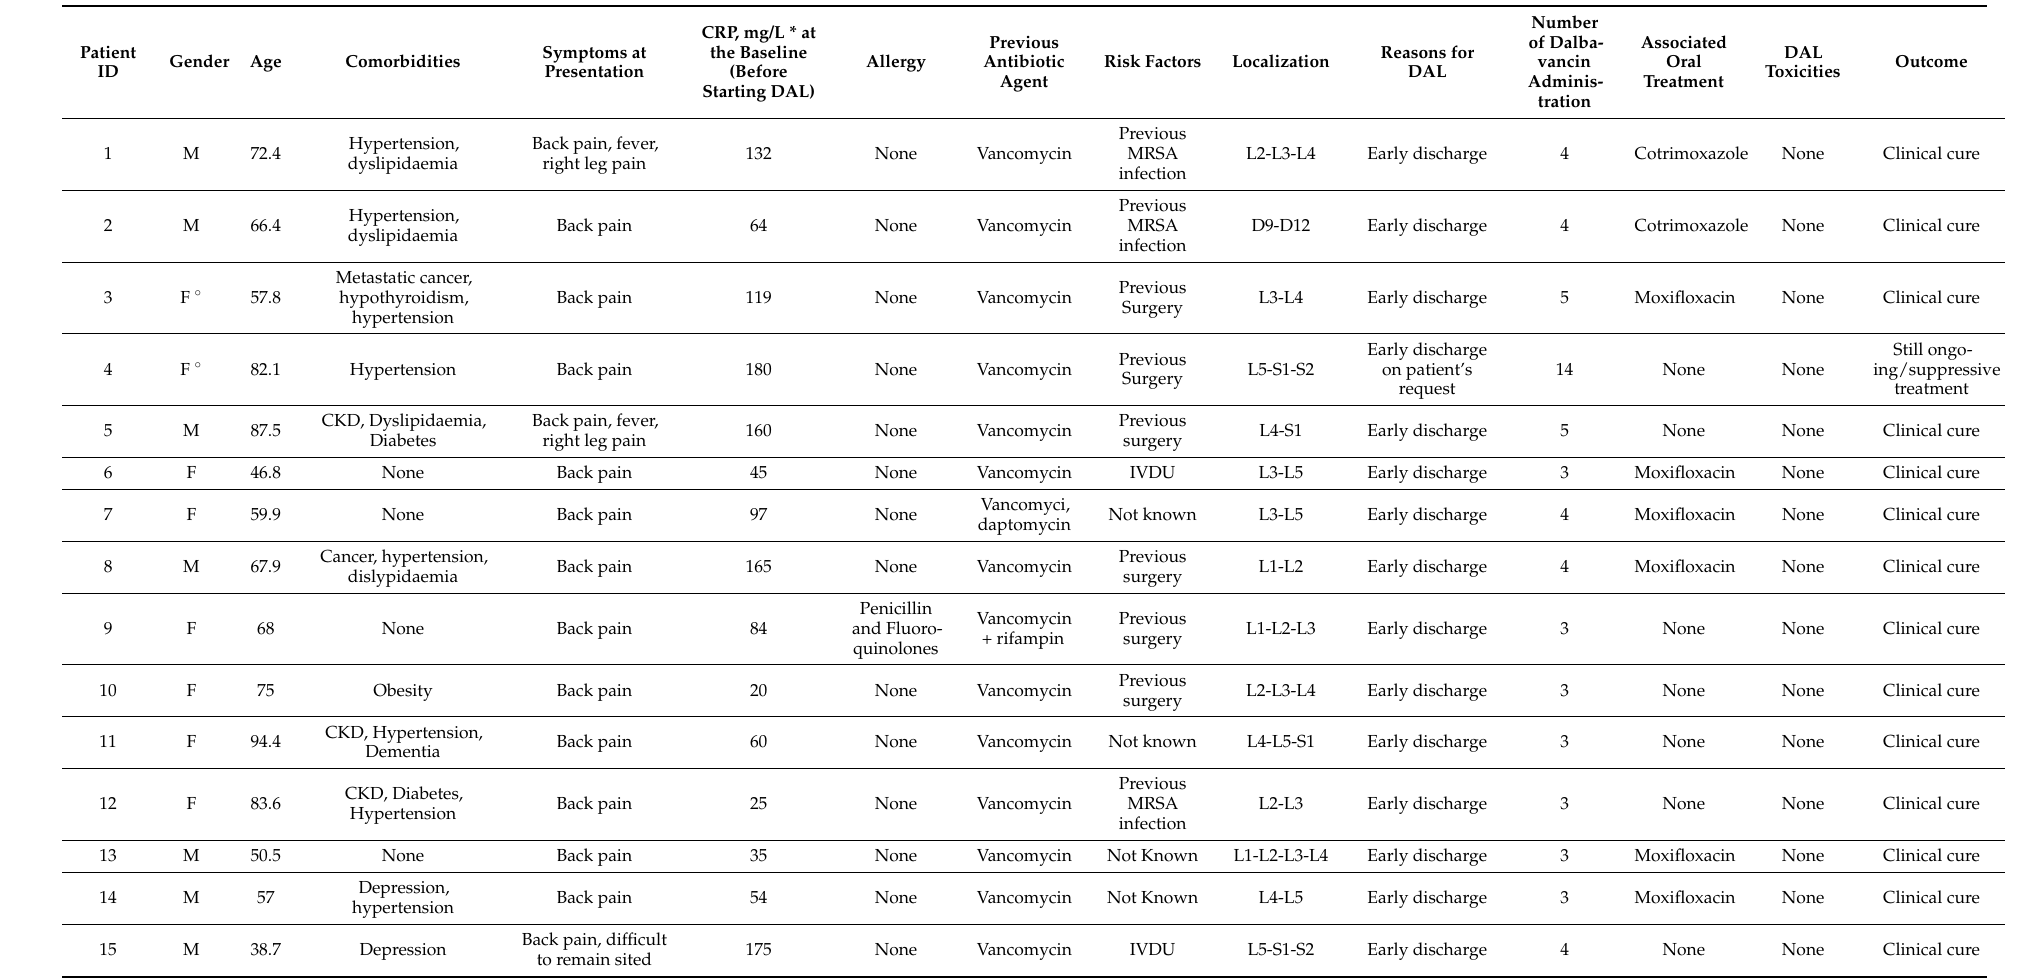
Legend to Table 1. F = female, M = male, CKD = chronic kidney disease, DAL = dalbavancin, IVDU = intravenous drug use, MRSA = methicillin-resistant Staphylococcus aureus , D = dorsal, L = lumbar, S = sacral, CRP = C reactive protein, * = mg/L, normal value < 5 mg/L, ◦ = patients with TDM monitoring